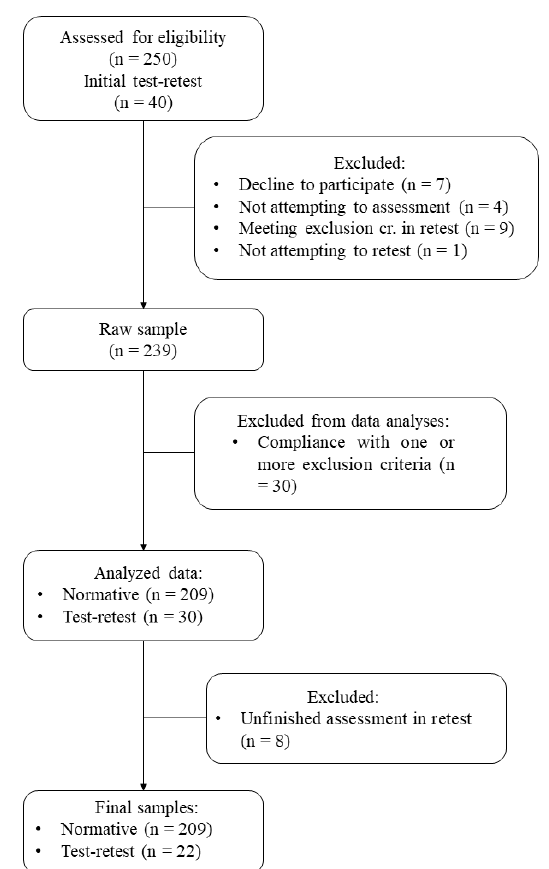
Figure 1. Participants’ flow chart. Source: elaboration based on the information obtained.